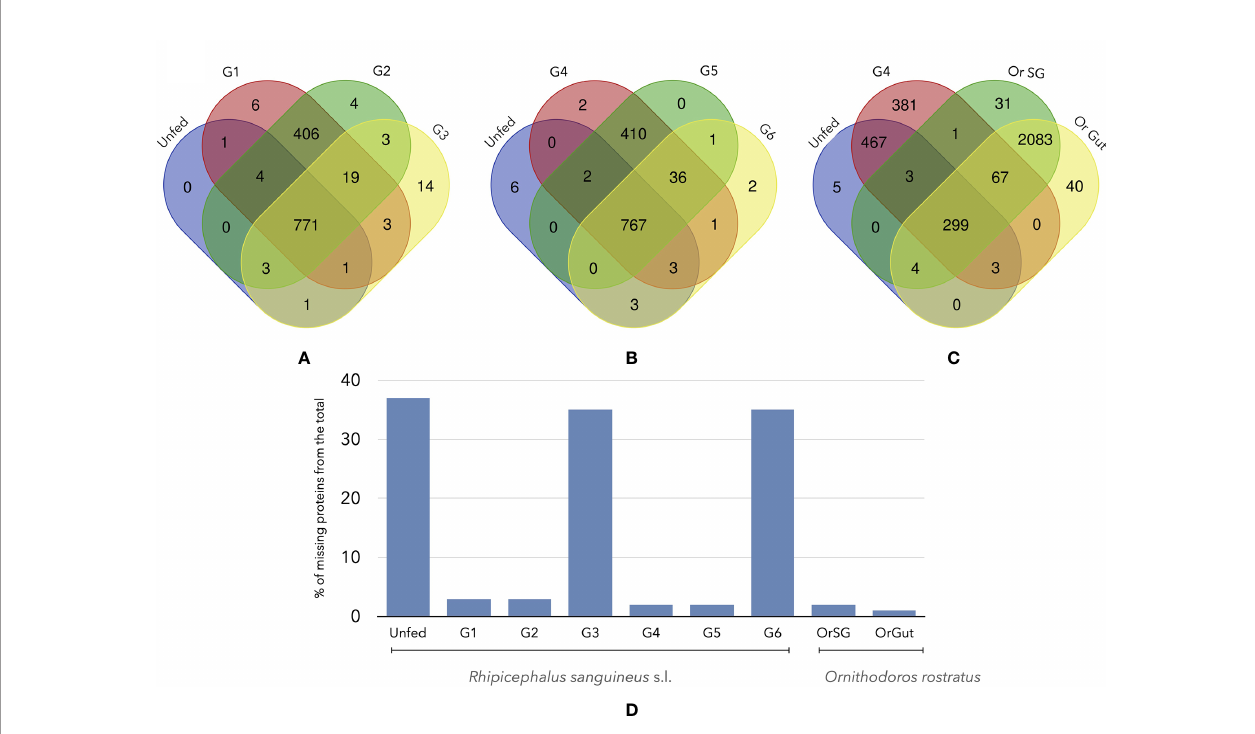
FIGURE 3 | Venn diagrams of the number of shared proteins among different groups of unfed or fed R. sanguineus ticks and/or O. rostratus . (A) R. sanguineus unfed, G1, G2, and G3; (B) R. sanguineus unfed, G4, G5, and G6; (C) R. sanguineus unfed, G4, and O. rostratus salivary glands or gut. The terminology of groups of feeding R. sanguineus follows Tirloni et al. (2020). The intersection of each diagram shows the number of shared proteins between these speci fi c groups. (D) Histogram show the quantity of proteins that are non-present of the total of each tick